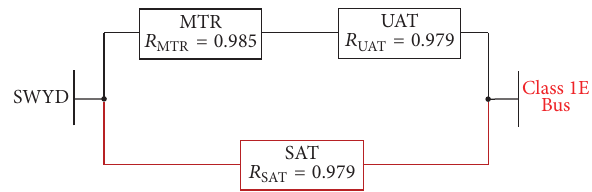
Figure 7: Existing electric power system reliability block diagram for Class 1E Bus.